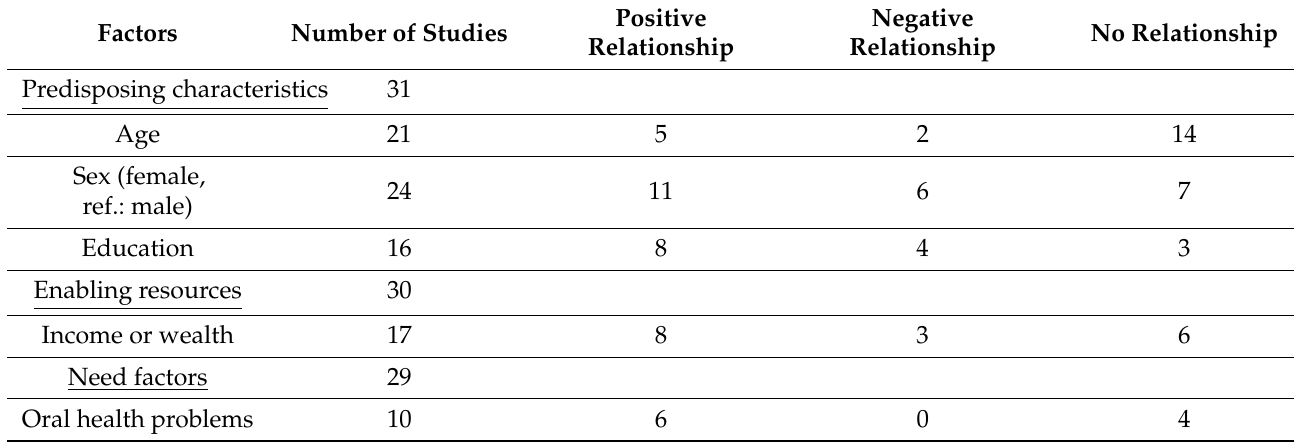
Table 5. Key findings